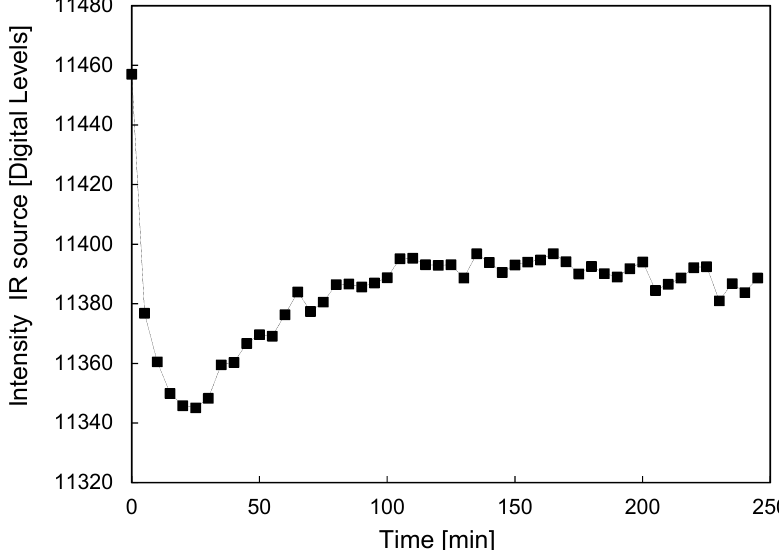
Figure 5. Variation of measured IR intensity as a function of time in an empty quartz column fed with N 2 once the IR source has reached the target set point (430 °C)